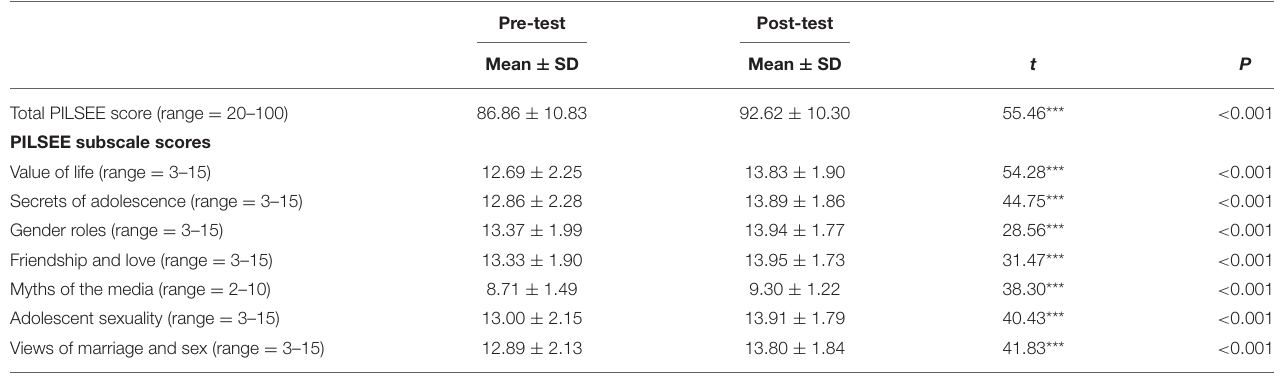
TABLE 1 | Pretest and posttest scores for students and differences between scores on the PILSEE ( N = 10,506).